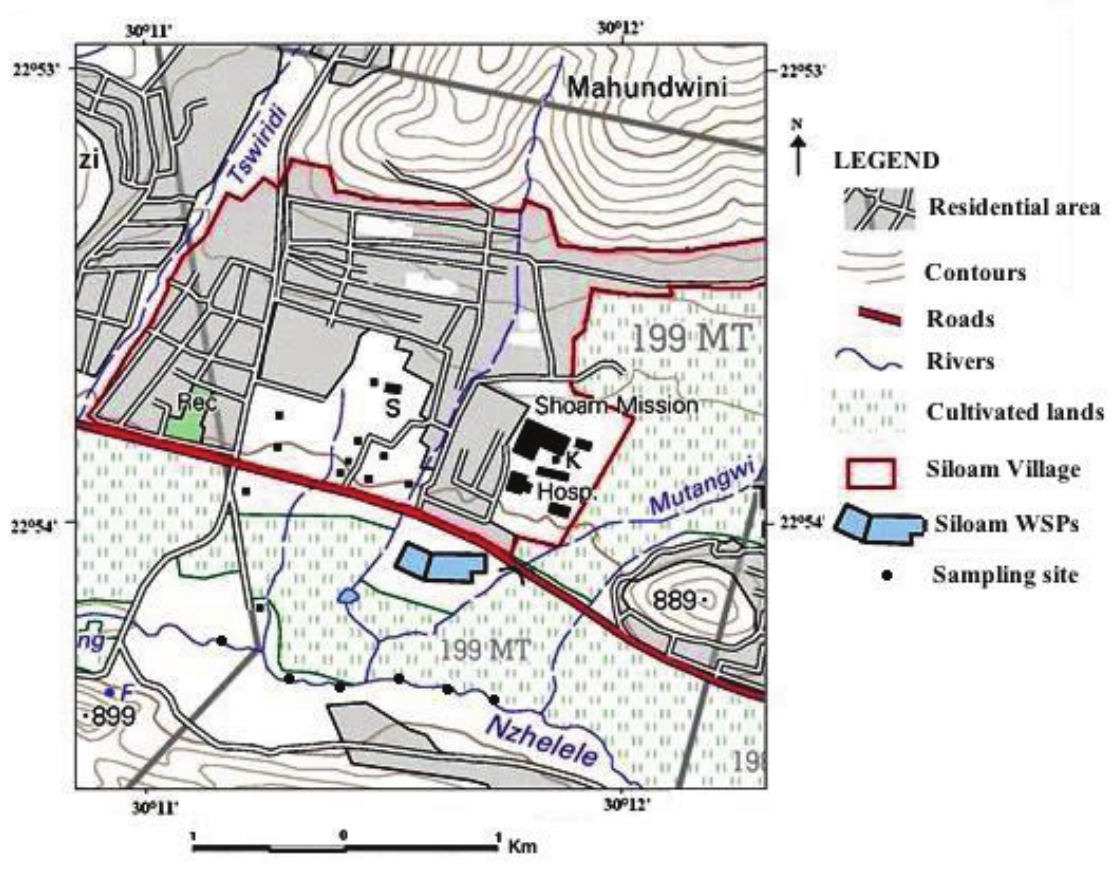
Figure 1: Map of the study area